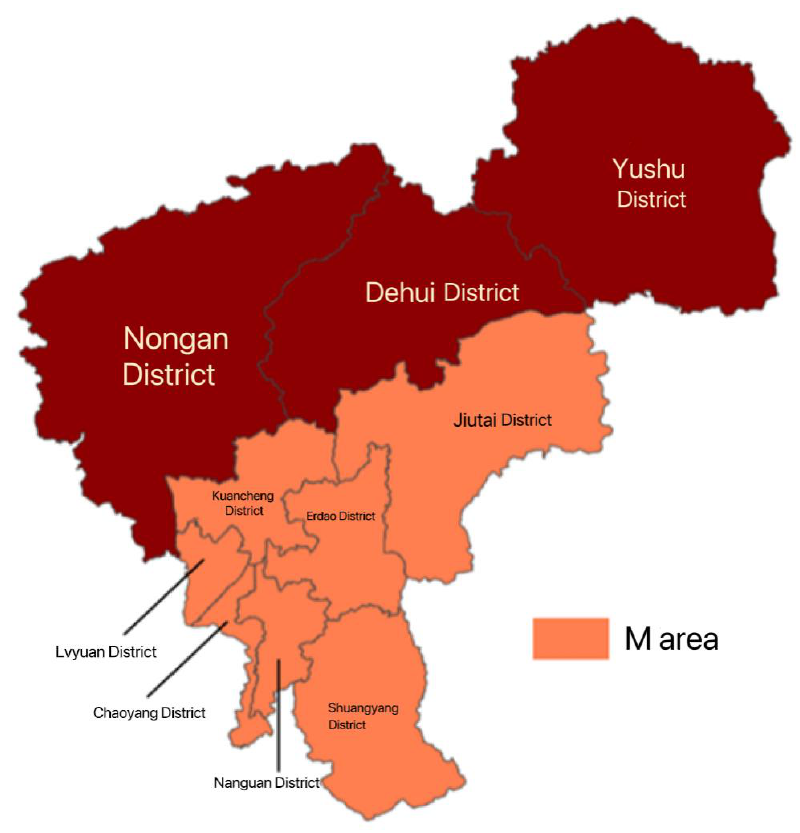
Figure 2. Regional map of M area .